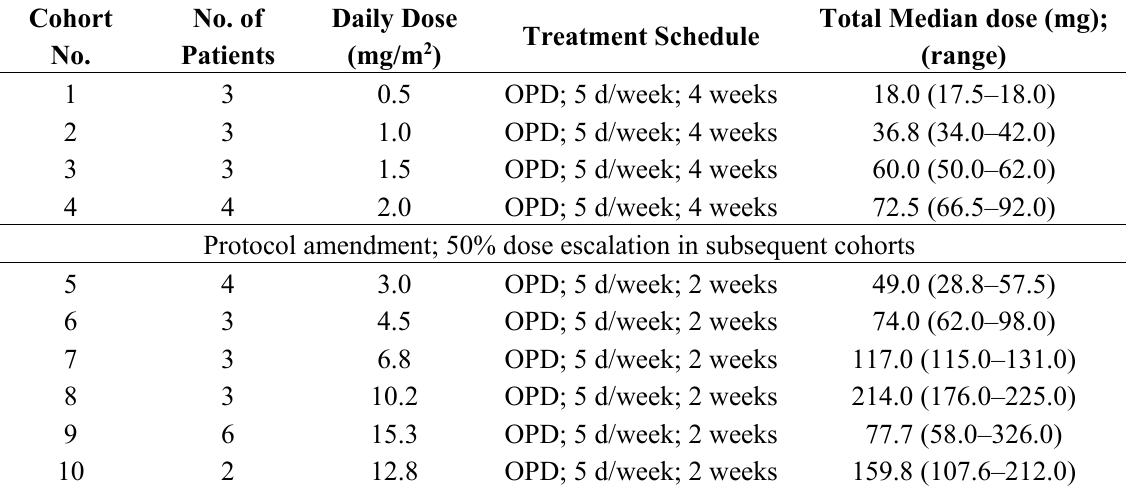
Table 1: Dose is expressed as “total” selenium equivalent, not as selenite. One patient in cohort 3 received 19/20 treatments and another patient in cohort 4 received 5/10 treatments. At 15.3 mg/m 2 dose, only one